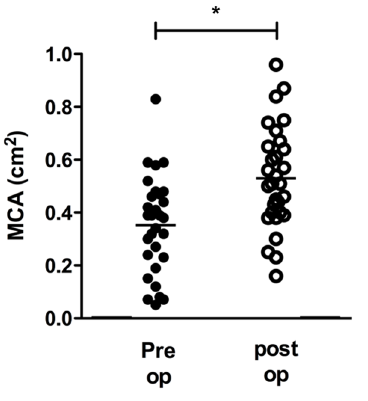
Figure 2. Changes in mean cross sectional area (MCA, cm 2 ), as measured by acoustic rhinometry, pre- and post-nasal surgery. * : p , 0.05 when comparing the pre-and post-operative values.